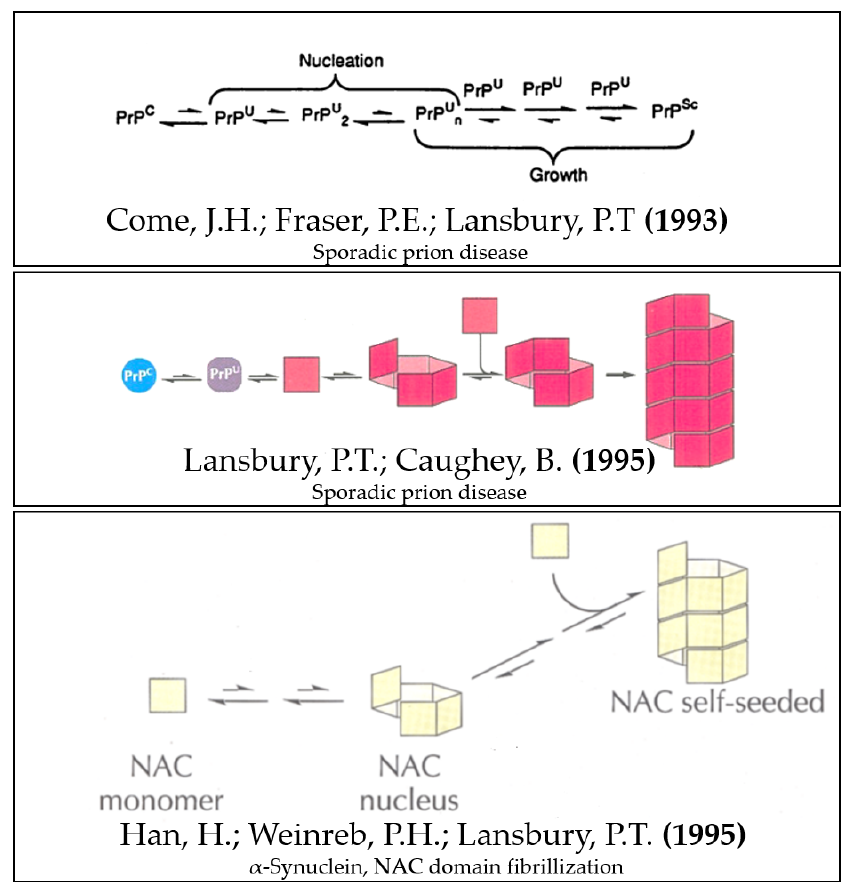
Figure 1. Lansbury’s unified seeding/templating model for sporadic prion disease and α -Synuclein fibrillization. Modified and composed from figures of references [1,3,4].